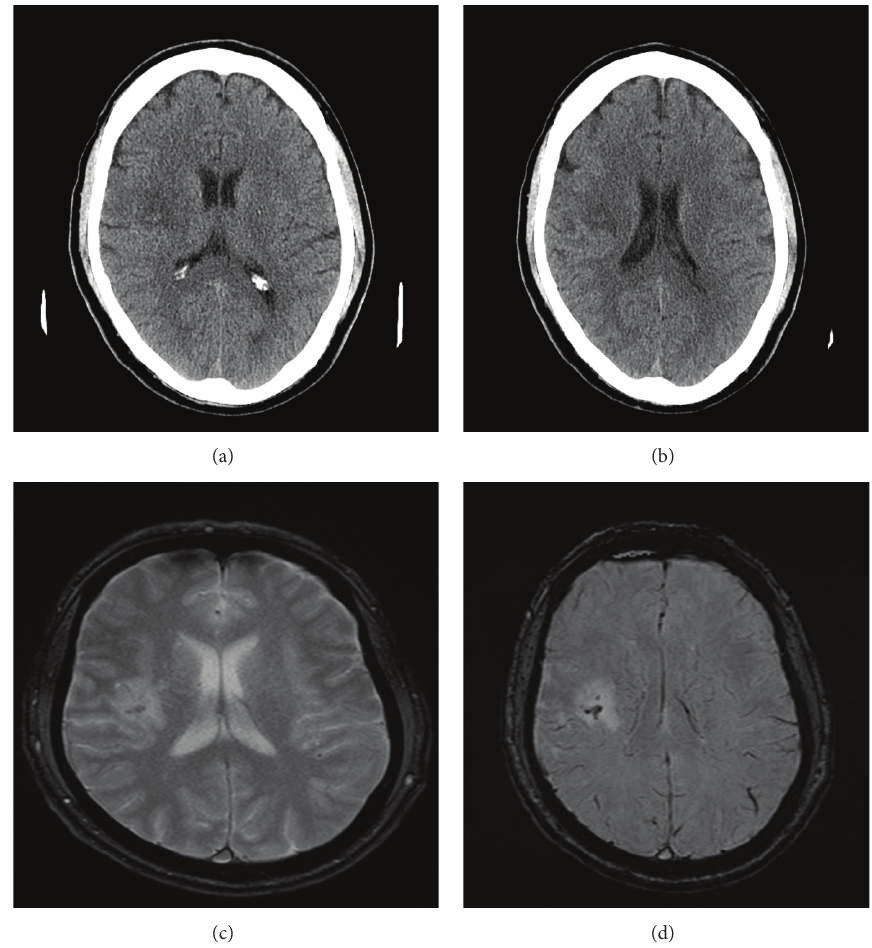
Figure 2: Subject presented with mild left hemiparesis. The day one CT (a) and (b) shows a small infarct in the right subcortical white matter, with a suggestion of increased signal within the central portion. The gradient echo (c) and susceptibility weighted image (d) MRI sequences performed on day seven suggest a small amount of blood within the infarct. No clinical deterioration was detected.